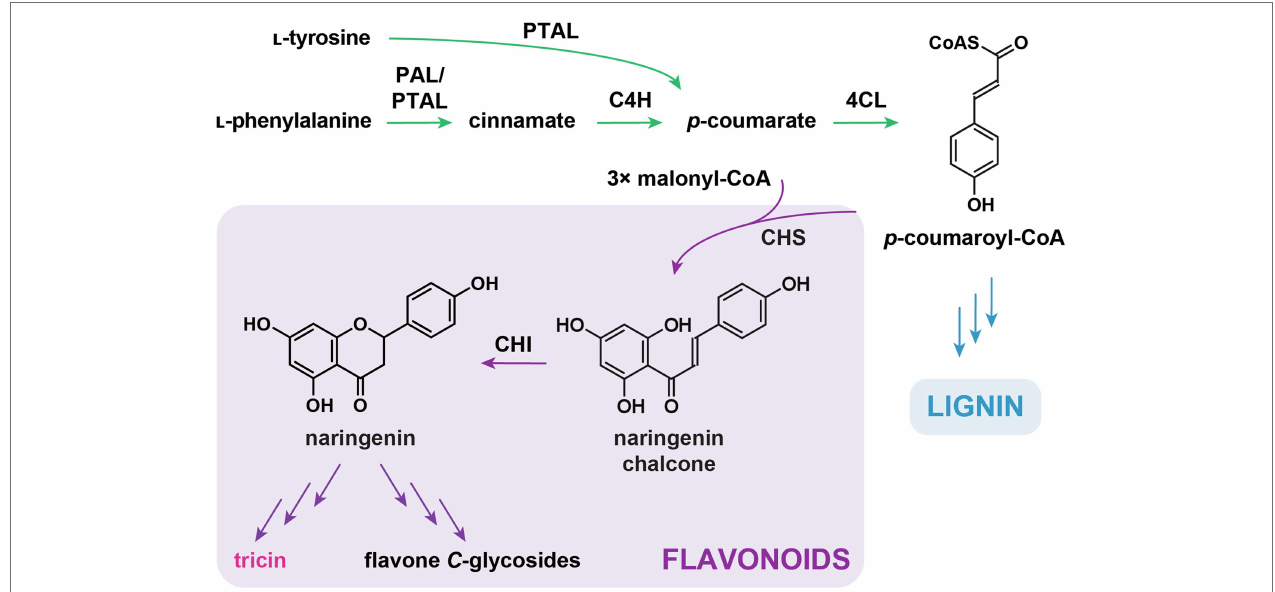
FIGURE 2 | General phenylpropanoid pathway and early flavonoid biosynthetic pathway. PAL, ʟ -phenylalanine ammonia-lyase; PTAL, ʟ -phenylalanine/ ʟ -tyrosine ammonia-lyase; C4H, cinnamate 4-hydroxylase; 4CL, 4-hydroxycinnamate:CoA ligase; CHS, chalcone synthase; and CHI, chalcone isomerase. In green: general phenylpropanoid pathway. In purple: flavonoid biosynthetic pathway. In blue: monolignol biosynthetic